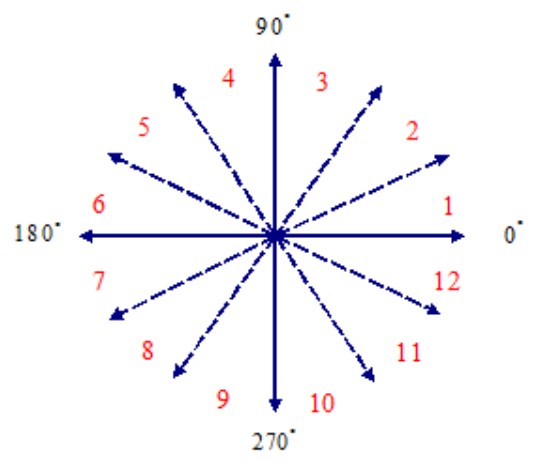
Figure 5. Diagram of angle interval